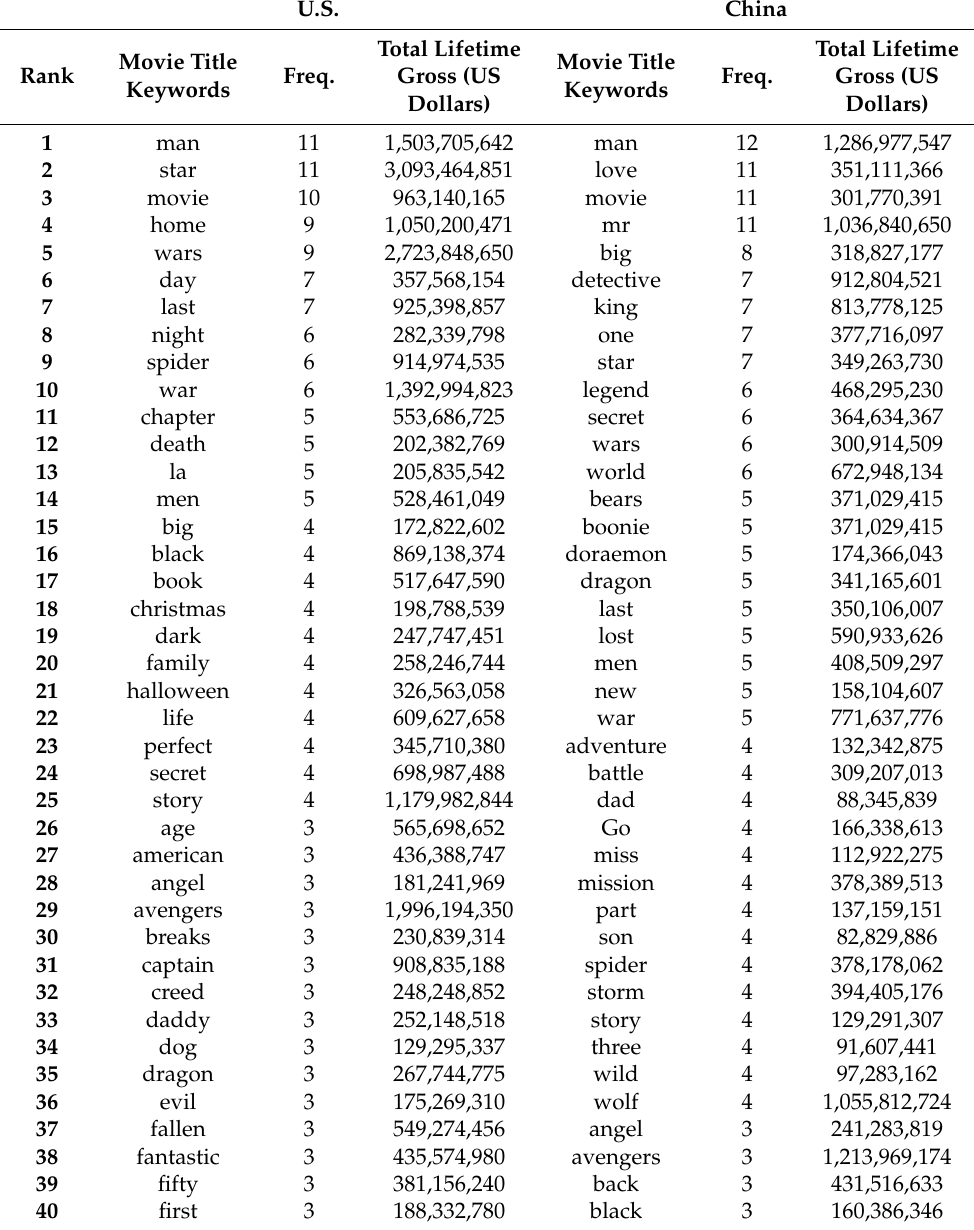
Table 1. Descriptive statistics of the 50 most popular movies in the United States and